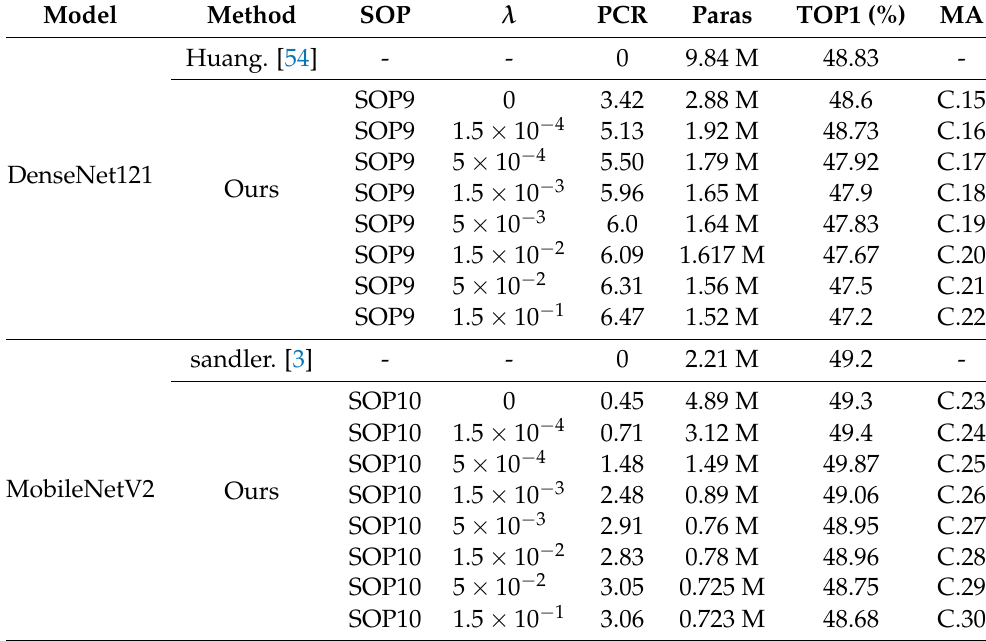
Table 5. Results of compressing DenseNet121 and MobileNetV2 on ImageNet-16-120.